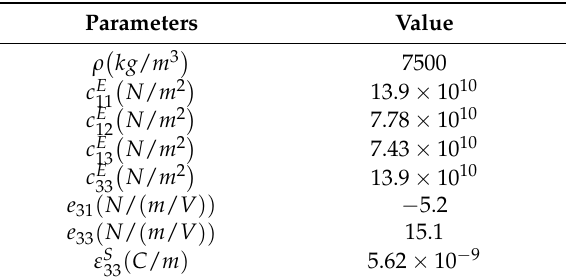
Table 1. Standard parameters of PZT-4.